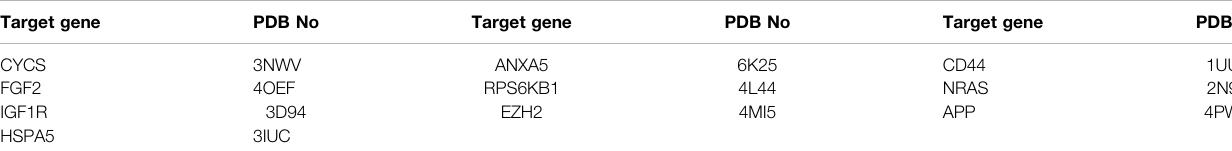
TABLE 6 | Gene chip model and PDB numbers.